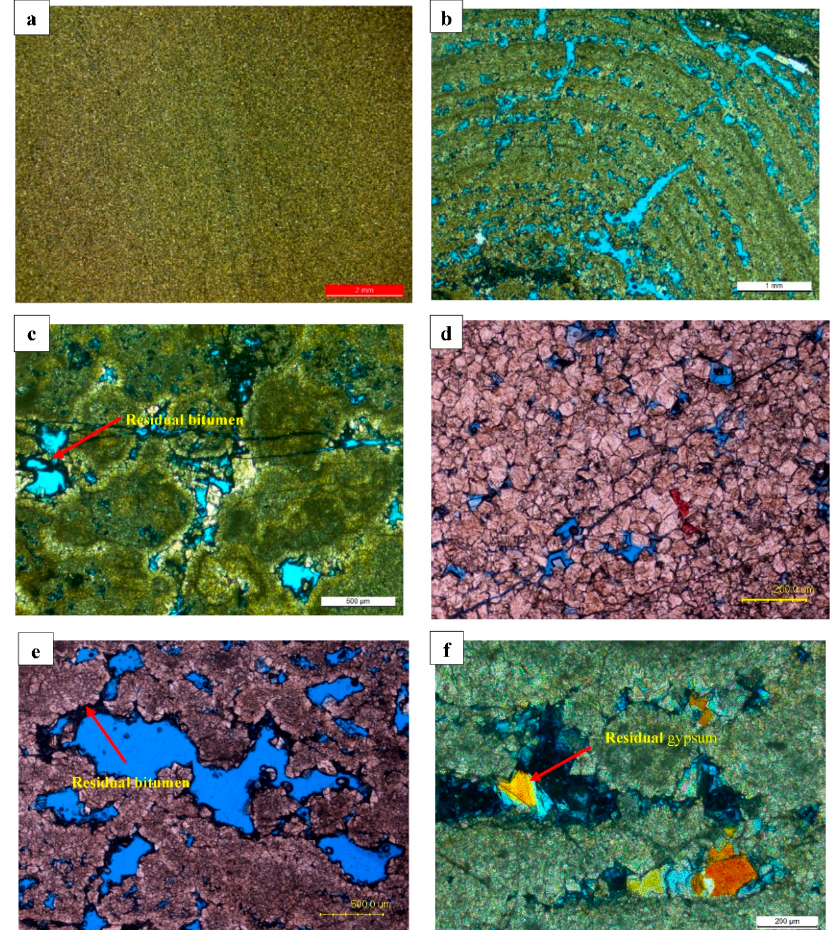
Figure 2. Photomicrographs of the Leikoupo Formation dolomites. ( a ) Well Yas1, 5774.42 m, dolomicrite; ( b ) Well Ys1, 6200.39 m, algal framework dolomite, algal framework pores; ( c ) Well Ys1, 6223.63 m, dolomite with precursor carbonate grain textures, intergranular dissolution pores; ( d ) Well Ys1, 6197.21 m, fabric-destructive dolomite, intercrystalline pores; ( e ) Well Ys1, 6219.66 m, moldic pores, residual bitumen; and ( f ) Well Ys1, 6215.38 m, residual gypsum, moldic pores, intergranular dissolution pores.